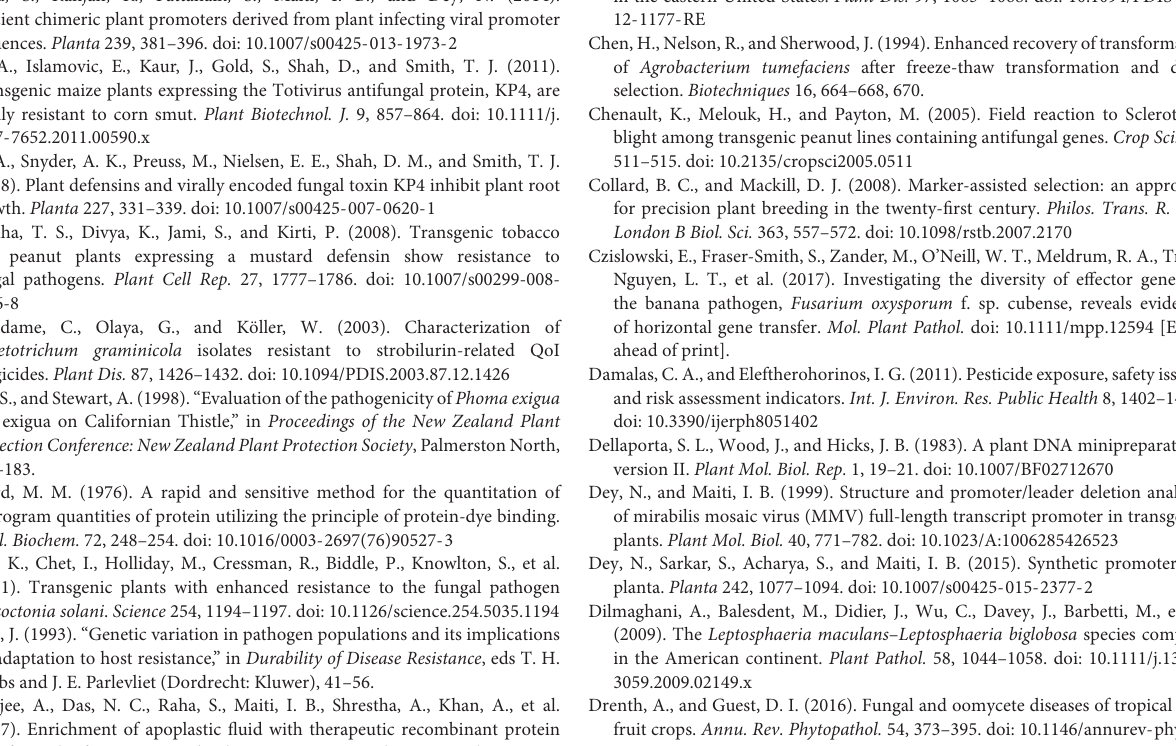
FIGURE S1 | Transient agro-infiltration assays to evaluate the GUS expression in whole plants of (A) Nicotiana tabacum (B) Petunia hybrida, and (C) Solanum lycopersicum expressing GUS under respective promoter constructs along with VC leaves. FIGURE S2 | Spatial distributions of GUS activities under VC, CaMV35S, CaMV35S 2 , and MUASCsV8CP promoters. GUS activities (in nmole MU/min/mg protein) from the (A) root, (B) stem, and (C) leaf of transgenic tobacco seedlings (21 days old) expressing GUS under the control of the above promoter constructs were measured. Average GUS activities from three independent experiments for each of the promoter construct were presented with corresponding SDs. FIGURE S3 | In vitro agar plate diffusion assays using transiently expressed KP4-His. Equal amounts of TSP extracted from tobacco leaves infiltrated with constructs MUASCsv8CP-KP4His and CaMV35S 2 -KP4His were used to compare the inhibitions conferred against (A,B) Alternaria alternata and (C,D) Phoma exigua var. exigua , respectively. Sterile PBS and water were used as controls. FIGURE S4 | In vitro agar plate diffusion assays against Verticillium dahliae. Wells on each side of the fungal growth represent the VC and KP4L2 lines viz. KP4L2#2